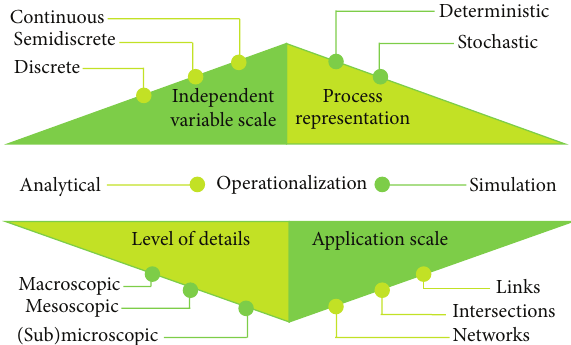
Figure 1: Categorization of traffic flow